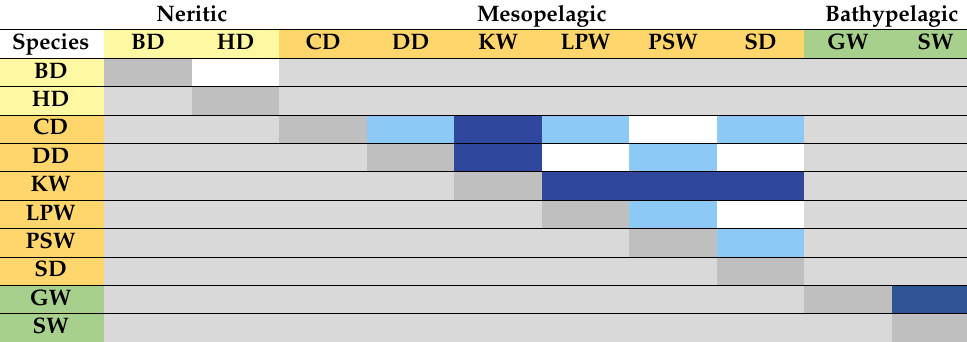
Table 2. Pairwise comparisons (randomisation test) of δ 13 C and δ 15 N isotopic values be- tween odontocete species with n ≥ 10 within each habitat group. Colour denotes the level of difference (at 0.05 significance level): dark blue = difference in both δ 13 C and δ 15 N isotopic values, light blue: difference only in δ 15 N isotopic values, white = no difference. Neritic group (yellow): BD = bottlenose dolphin, HD = Hector’s dolphin, mesopelagic group (orange): CD = common dolphin, DD = dusky dolphin, KW = killer whale, LPW = long-finned pilot whale, PSW = pygmy sperm whale, SD = striped dolphin, bathypelagic group (green): GW = Gray’s beaked whale, SBW = southern bottlenose whale, SW = sperm whale. Dark grey indicates matrix diagonal, light grey fields refer to species not in the same habitat. See Table A1 for p -values. Neritic Mesopelagic Bathypelagic Species BD HD CD DD KW LPW PSW SD GW